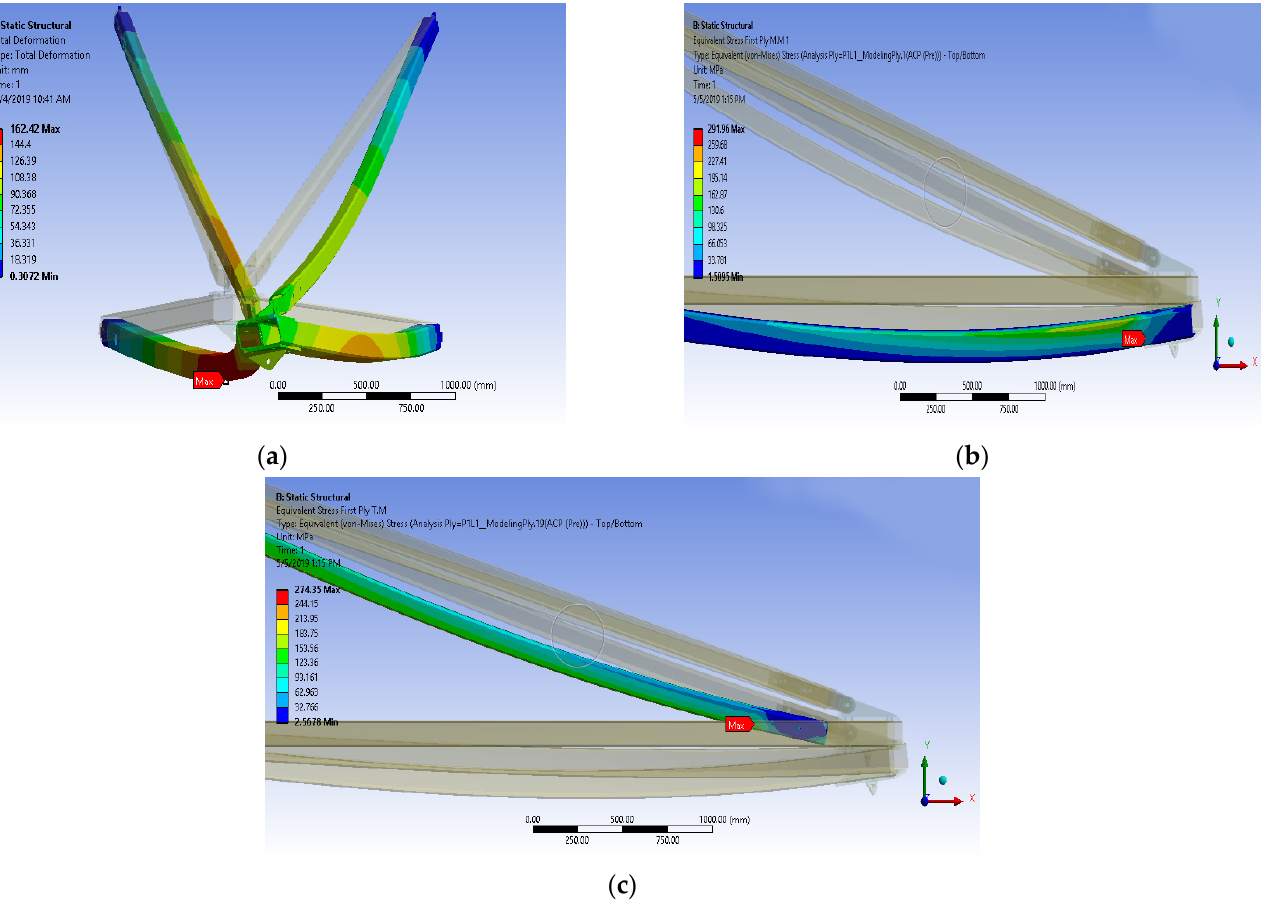
Figure 9. ( a ) Maximum deformation of GFRP cross-arm in broken wire condition ( b ) Equivalent stress ply first layer of the main member ( c ) Equivalent stress ply first layer of tie member.